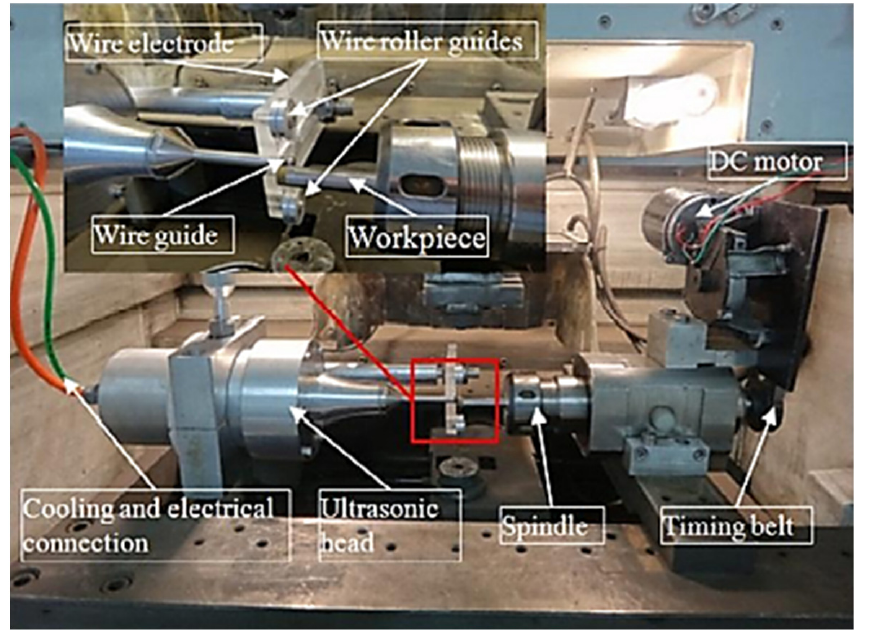
Figure 10. Rotary setup with ultrasonic head in five-axis WTET machine (Reprinted/Adapted with permission from [44]. 2013, Elsevier. ©).